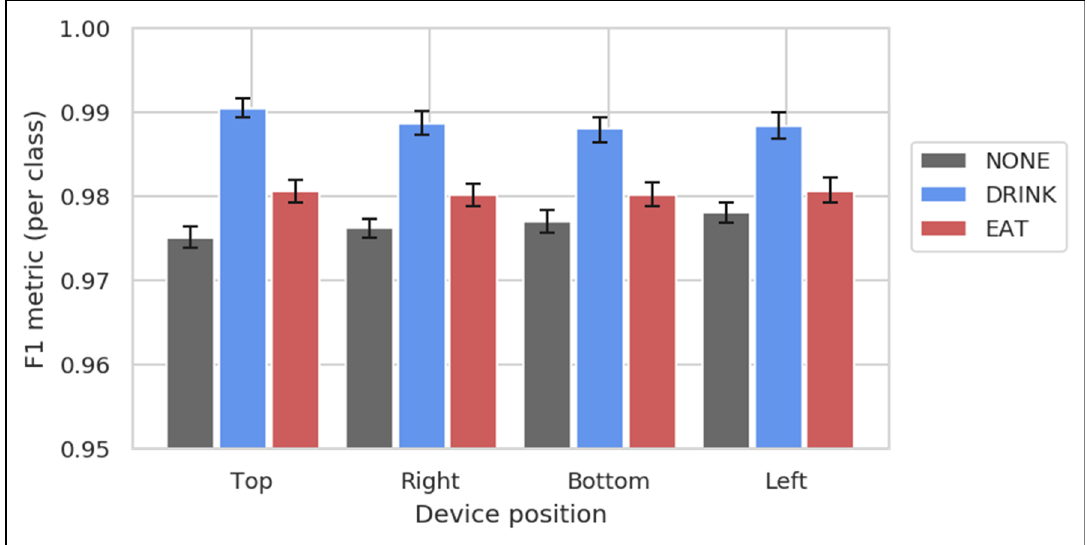
Figure 7. Classification performance as measured by F1 score. F1 scores measuring test accuracy are broken out by device position, for n = 48 videos from the eat/drink dataset where the dog’s collar had exactly four attached devices with known orientation. Error bars are 95% confidence intervals on the mean, as determined by bootstrapping. The classification accuracy per class was similar between the four positions, indicating that system accuracy is not substantially affected by collar rotation.